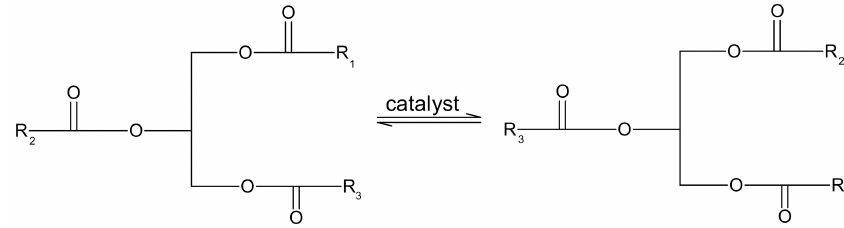
Figure 1. Plausible chemical interesterification